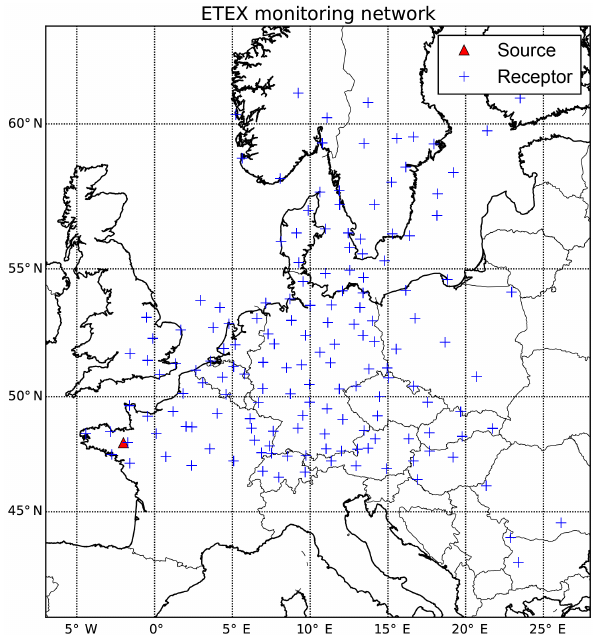
Figure 3. Domain of the ETEX experiment with source (red trian- gle) and receptors (blue